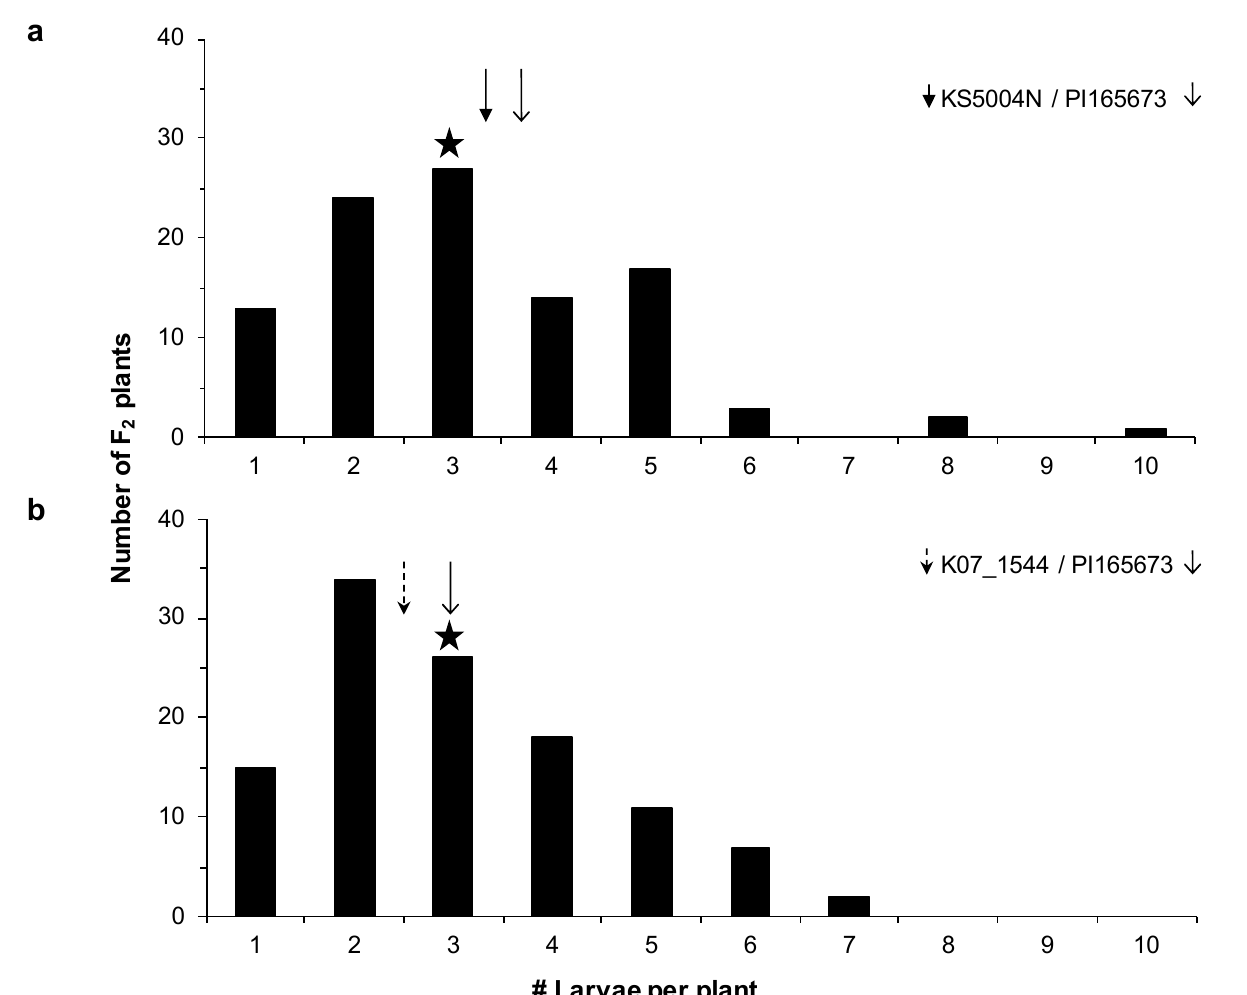
Figure 3. Frequency distributions of number of larvae per plant in F 2 soybean populations from ( a ) KS5004N/PI165673 and ( b ) K07-1544/PI165673 at 21 d post infestation with Dectes texanus in 2011. Arrows and stars indicate parent and F 2 means, respectively. The OL antibiosis ratio was significantly greater in PI165673 plants than K07-1544 plants in 2012 (F 1, 103 = 4.37, p < 0.05; Table 2). The numbers of oviposition punctures, numbers of larvae, larval head capsule widths, and larval body